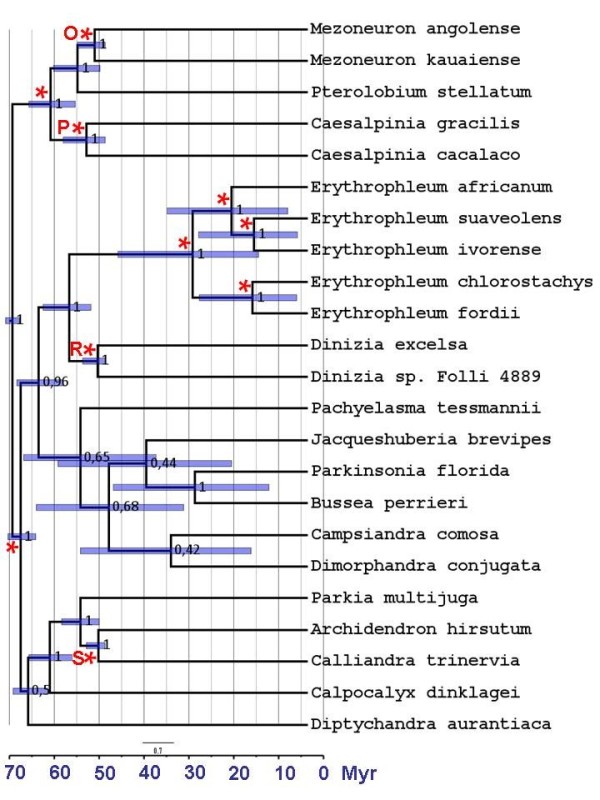
Divergence time chronogram of the Bayesian maximum clade credibility tree based on the chloroplast fragments matK and trnL. The blue bars represent the 95% highest posterior density intervals for each divergence time. Fossil calibration nodes are indicated by letters (P, O, R and S) as in [32]. Nodes constrained to be monophyletic are indicated by *. Numbers at internal nodes represent clades posterior probabilities.